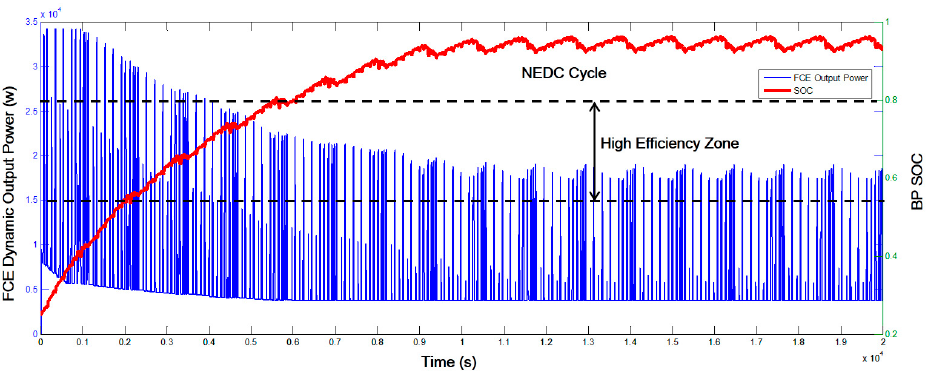
Figure 11. Vehicle control algorithm evaluation testing under the NEDC cycle with battery pack SOC and FCE dynamic output power parameters. Energies 2018 , 11 , x FOR PEER REVIEW